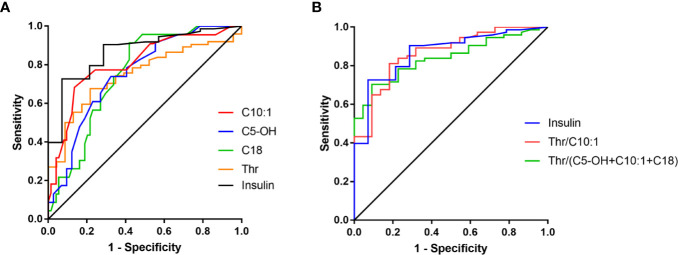
ROC curves of amino acids and acylcarnitines (A) and their combinations (B).